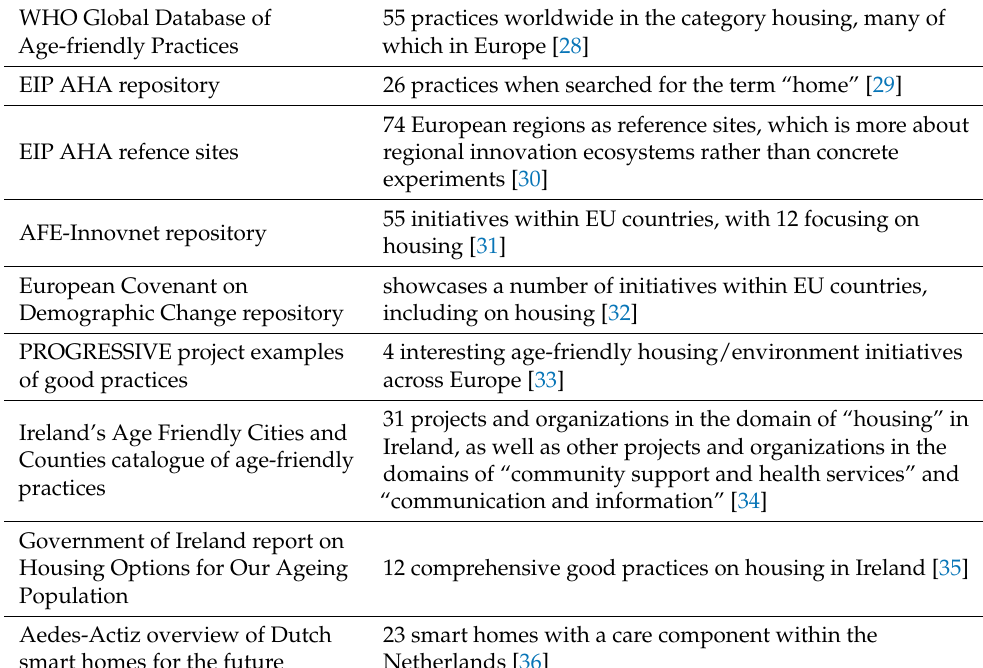
Table 1. Overview of repositories of good and innovative practices related to age-friendly